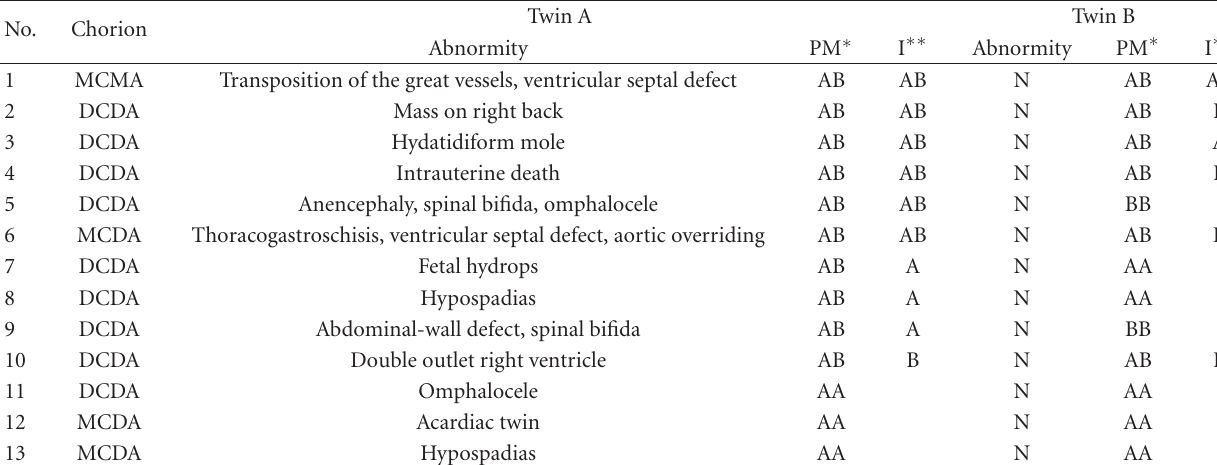
Table 1: Detail description of phenotype discordant in T2